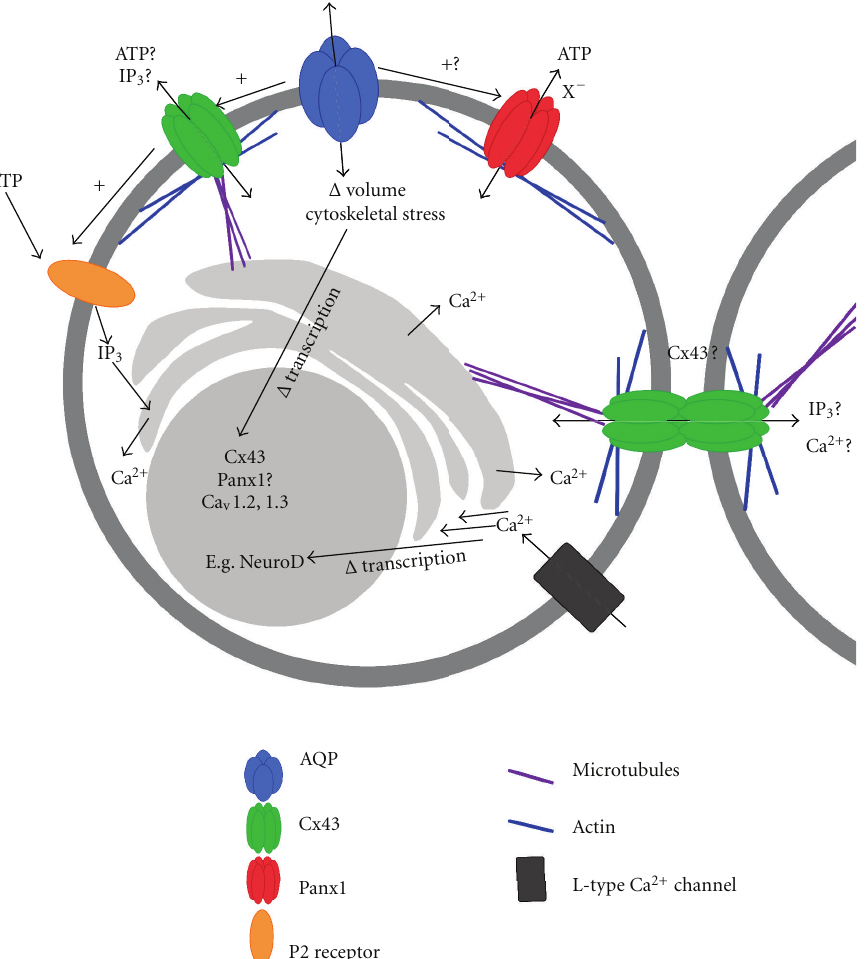
Figure 1: Schematic illustration of the interplay between AQP4, Cx43 and Panx1 large pore channels as they mediate cytoskeletal interac- tions, Ca 2+ signaling, transcriptional regulation, ATP flux, and cell-cell communication between VZ NSC/NPCs.